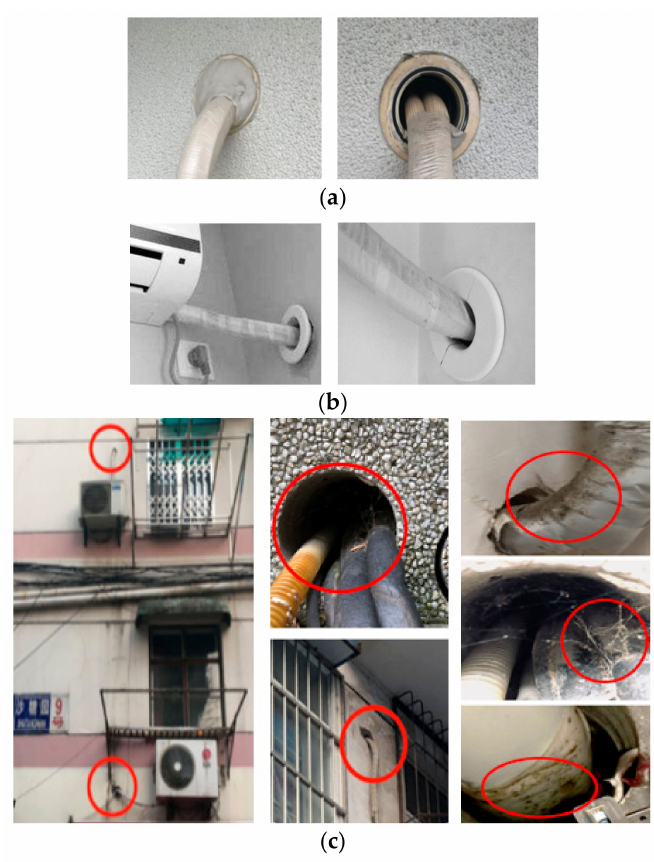
Figure 1. Air cavity through which air conditioner pipes pass: ( a ) a hole sealed with mud and the case after aging and shedding; ( b ) a hole through the wall of a newly built dwelling without sealing; ( c ) air conditioner pipe holes through the wall without sealing are very common in old buildings, and dust and mold